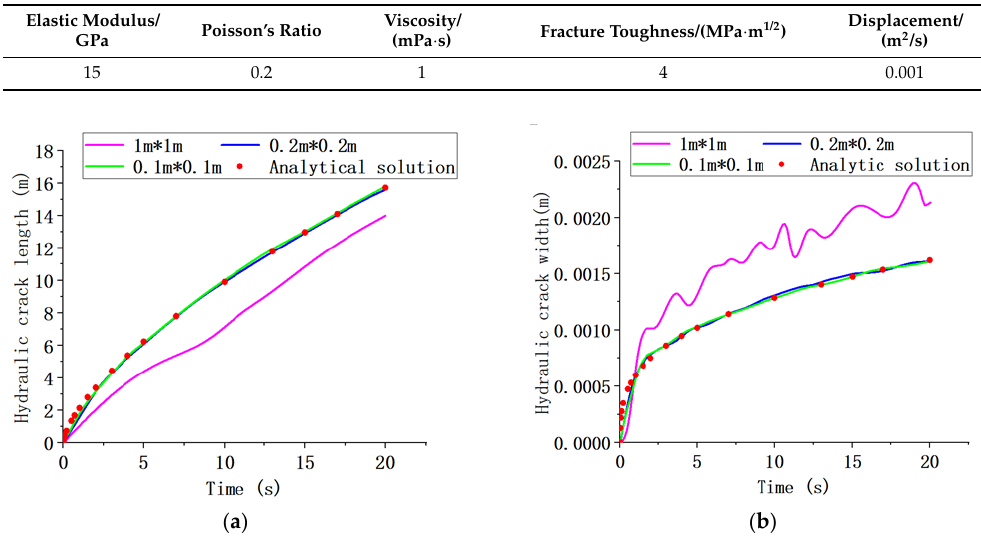
Figure 3. Comparison between analytical solution and numerical simulation results: ( a ) Comparison of hydraulic crack length; ( b ) Comparison of hydraulic crack width. The purple curve, blue curve and green curve represent the simulation results with grid sizes of 1 m × 1 m, 0.2 × 0.2 m and 0.1 × 0.1 m, respectively. The red dot represents the analytical solution result.